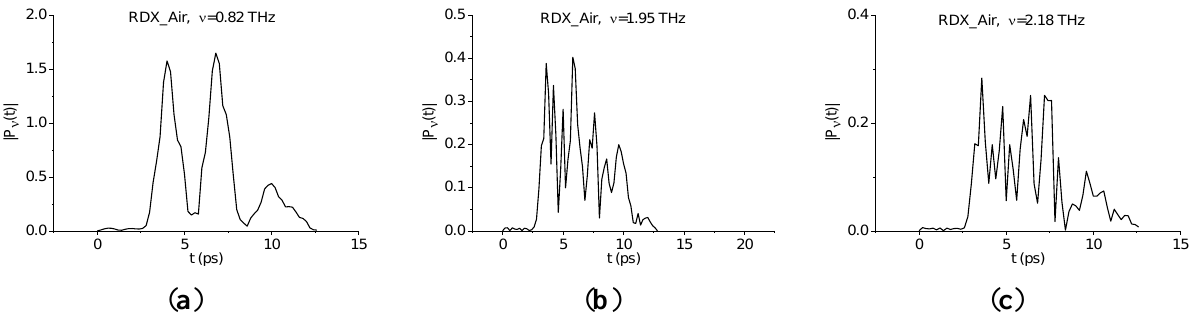
Figure 5. Time-dependent evolution of square root of the spectral intensity at frequencies ν = 0.82 THz ( a ); 1.95 THz ( b ); 2.18 THz ( c ) for the RDX_Air signal with a duration of about 10